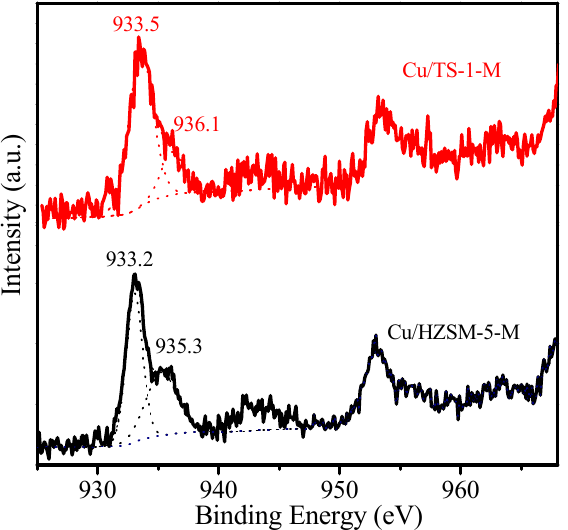
Figure 5. XPS spectra Cu 2p 3/2 of the Cu/HZSM-5-M and Cu/TS-1-M samples.